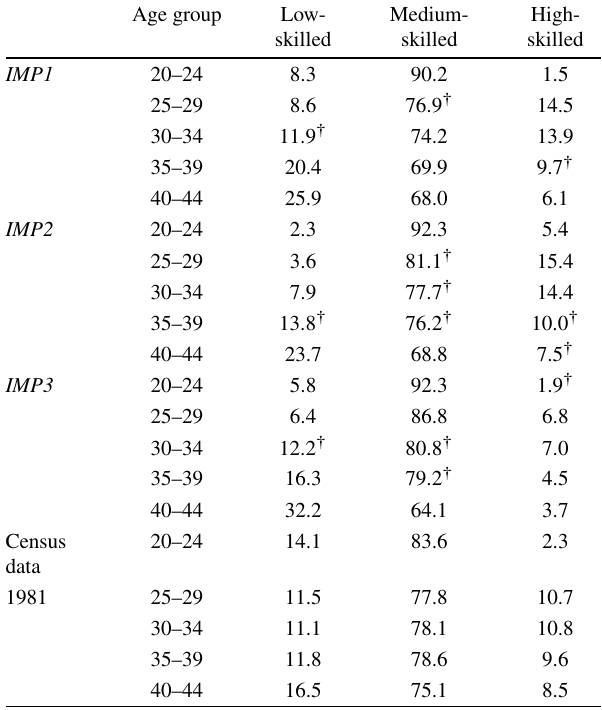
Table 7 Qualification structure by age groups – 1984,